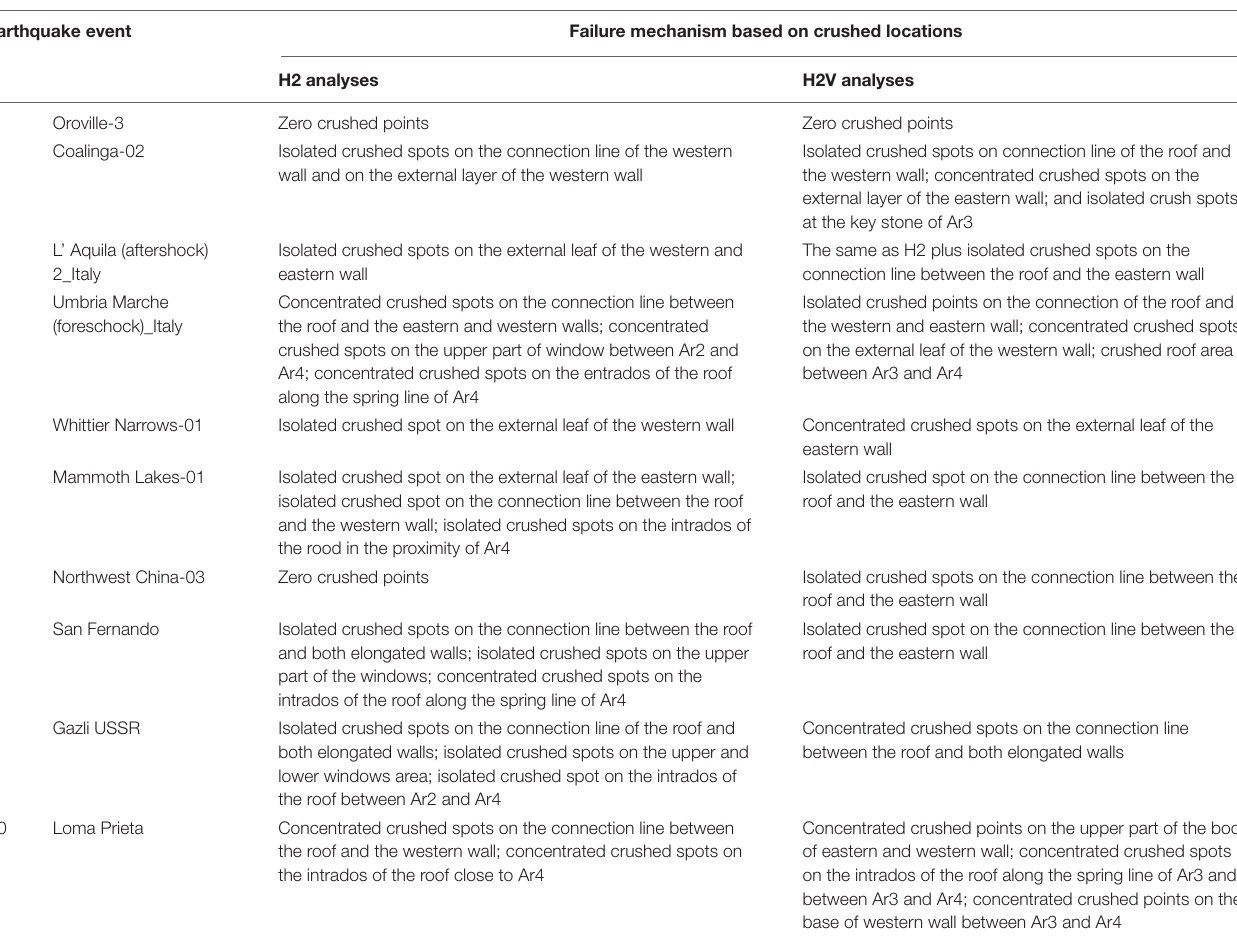
TABLE 2 | Failure mechanism based on crushed